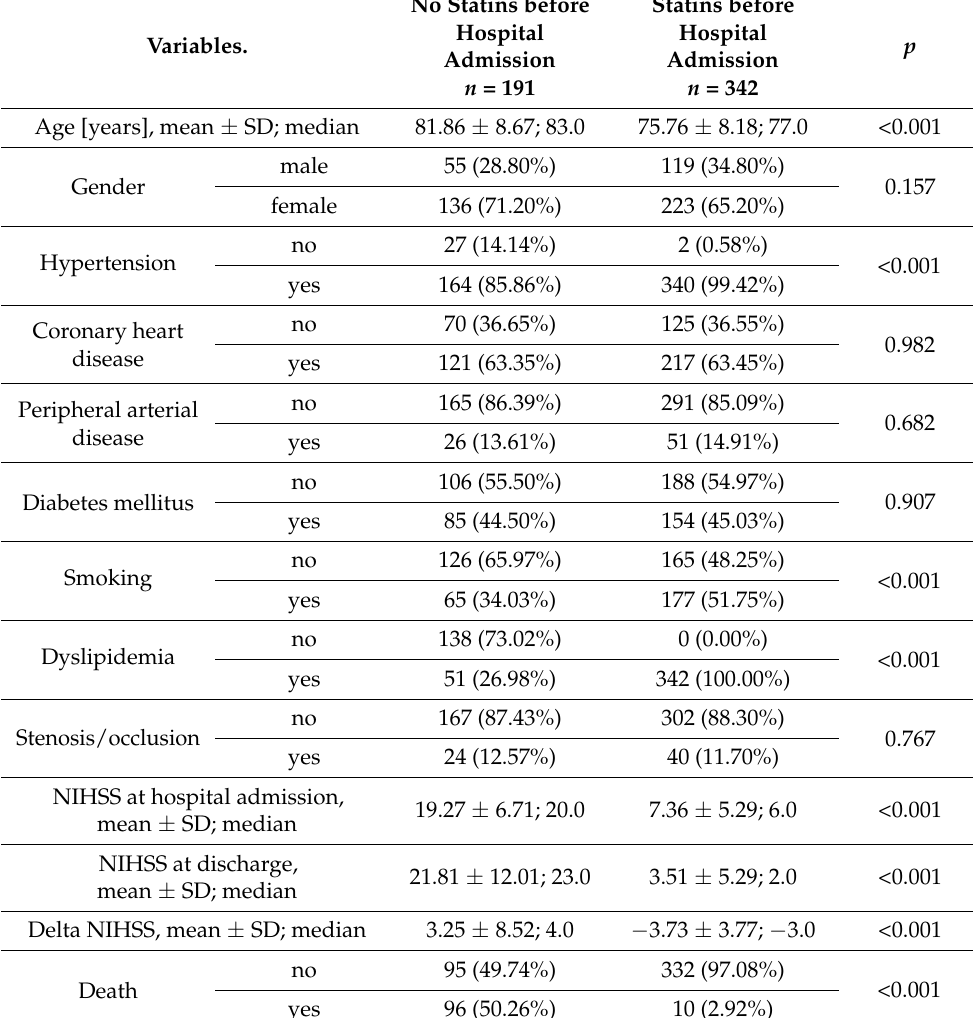
Table 1. Comparison of patients taking and not taking statins.